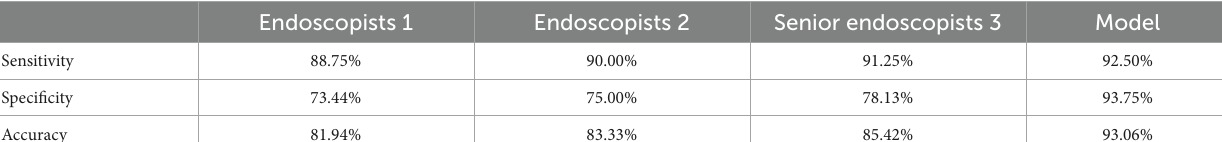
TABLE 4 Comparison of differences in diagnostic ability of colorectal adenoma between endoscopists with different levels and the colorectal adenoma recognition model.